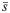
Bayesian approach used to model interoceptive awareness on the heartbeat tapping task.The generative model is here depicted graphically, such that arrows indicate dependencies between variables. Associated vectors/matrices are also shown. At each time point (t), observations (o) depend on hidden states (s), where this relationship is specified by the A matrix, and those states depend on previous states (as specified by the B matrix, or the initial states specified by the D vector). This model represents a simplified version of a commonly used active inference formulation of partially observable Markov decision processes (for more details regarding the structure and mathematics describing these models, see [76–78]). In this model, the observations were systole/diastole, and the hidden states included beliefs about the presence or absence of a heartbeat. Selection of the tap vs. no tap actions were sampled from the posterior distribution over states (s¯)—that is, a higher posterior probability of a heartbeat state (P(HB)) corresponded to a higher probability of choosing to tap, and a higher posterior probability of the no heartbeat state (P(nHB)) corresponded to a higher probability of choosing not to tap. The model parameters we estimated corresponded to: 1) interoceptive precision (IP)—the precision of the mapping from systole/diastole to beliefs about heartbeat/no heartbeat in the A matrix, which can be associated with the weight assigned to sensory prediction errors; and 2) prior beliefs favoring the presence of a heartbeat (pHB). Because minimal precision corresponds to an IP value of 0.5, and both higher and lower values indicate that taps will more reliably track systoles (albeit in an anticipatory vs. reactive manner), our ultimate measure of precision subtracted 0.5 from raw IP values and then took their absolute value. The raw IP values were then used to assess for group differences in the tendency to tap before vs. after each systole. We also compared this model to an analogous model that included learning (see main text). On each trial, beliefs about the probability of a heartbeat (corresponding to the probability of choosing to tap) relied on Bayesian inference as implemented in the “heartbeat perception” equations shown at the bottom of the figure. Note that, by convention in the active inference models from which our model was derived, the dot product (∙) applied to matrices here indicates transposed matrix multiplication. Observed diastoles and systoles were taken from EKG traces, after dividing the time series into periods before and after each systole (exemplified in the upper left portion of the figure; see text for details). Each time period in which a diastole or systole could be present was treated as a separate trial, in which the participant started in the “start” state and then updated beliefs about hidden states based on observation of a diastole or systole. For this reason, the pHB parameter in the transition matrix (B) only specifies the probability of transitioning from the “start” state to the heartbeat vs. no heartbeat states, and the heartbeat vs. no heartbeat states simply have identity mappings (i.e., a given trial cannot transition between these two states).